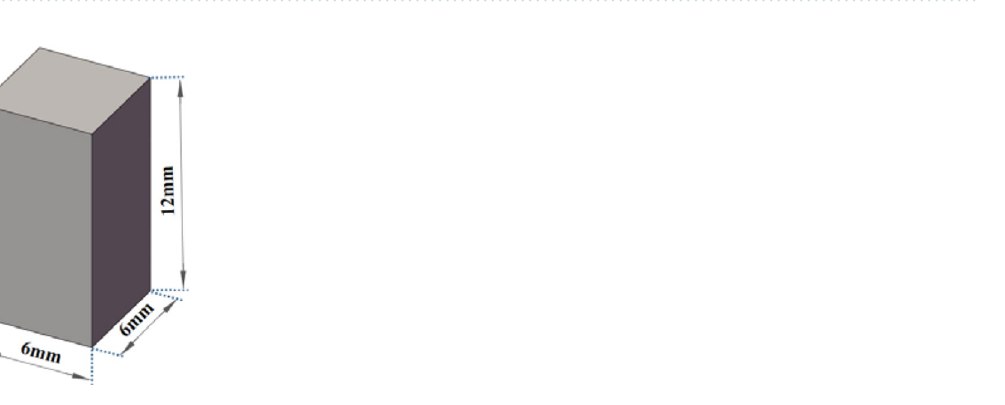
Figure 6. Size of tensile sample model.